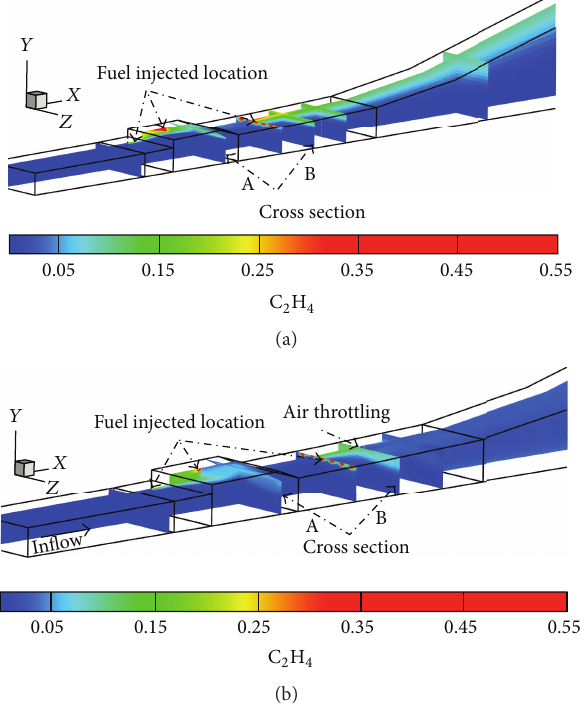
Figure 7: Fuel (ethylene) mass fraction of the scramjet combustor with and without air throttling ((a) case without air throttling; (b) case with air throttling).